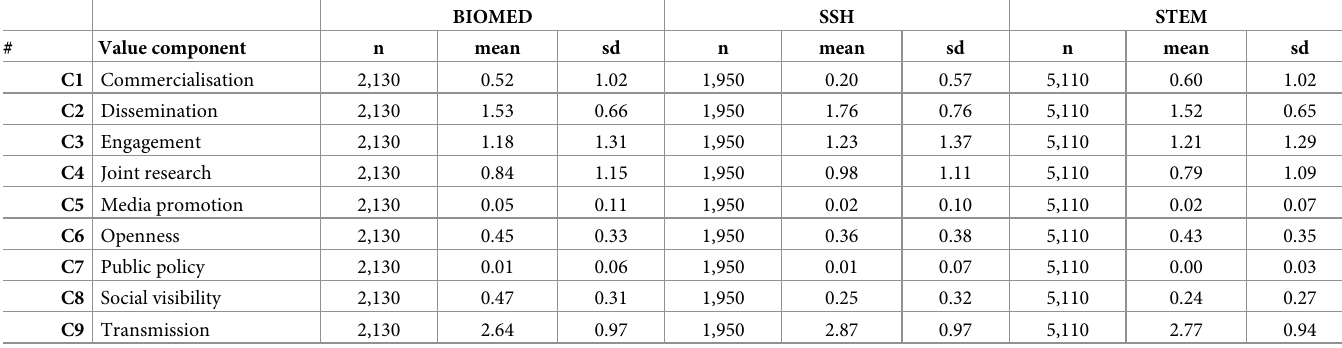
Table 5. Descriptive statistics, model components by scientific